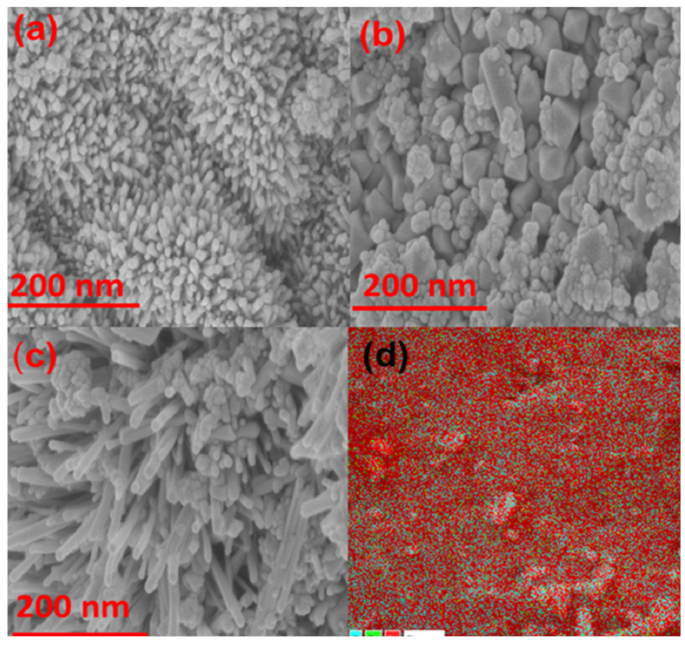
Figure 4. The SEM analysis of the bimetallic Sf ZnOSnO 2 nanomaterial at ( a ) 30:70, ( b ) 50:50, ( c ) 70:30 ratios and ( d ) the mapping